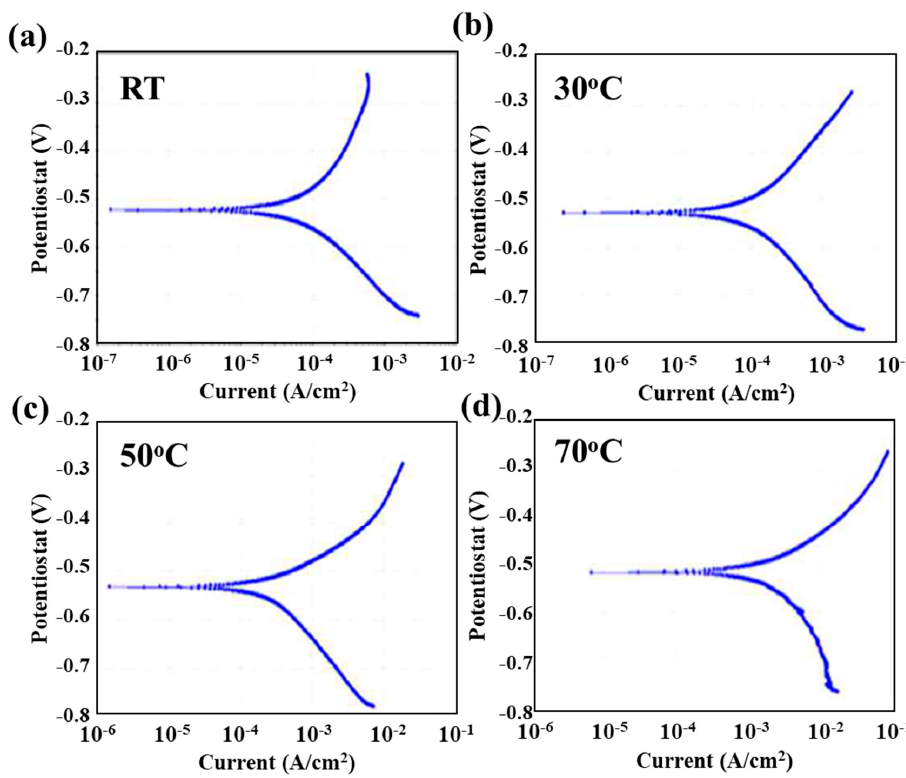
Figure 4. Potentiodynamic polarization curve of weldment couple before PWHT at ( a ) RT, ( b ) 30 °C, ( c ) 50 °C and ( d ) 70 °C. Table 3. Effect of PWHT on the corrosion characteristics at various temperatures.